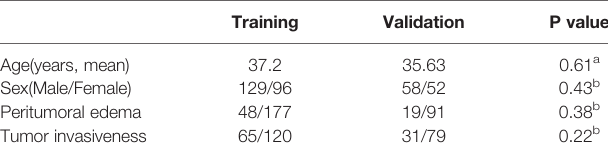
TABLE 1 | Patient characteristics.